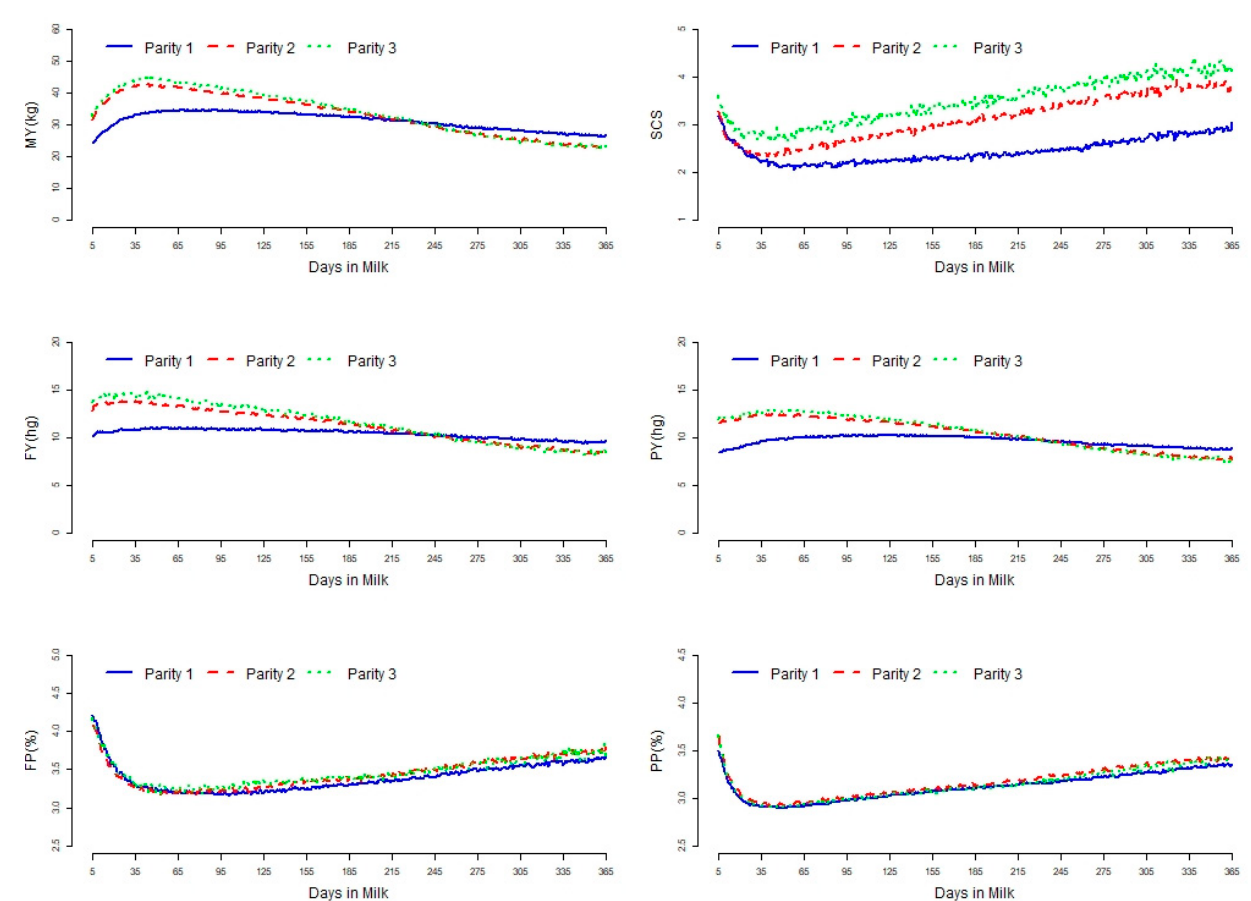
Figure 1. Lactation curve for daily milk yield (MY), SCS, fat yield (FY), protein yield (PY), fat percentage (FP), and protein percentage (PP) in the first three parities.